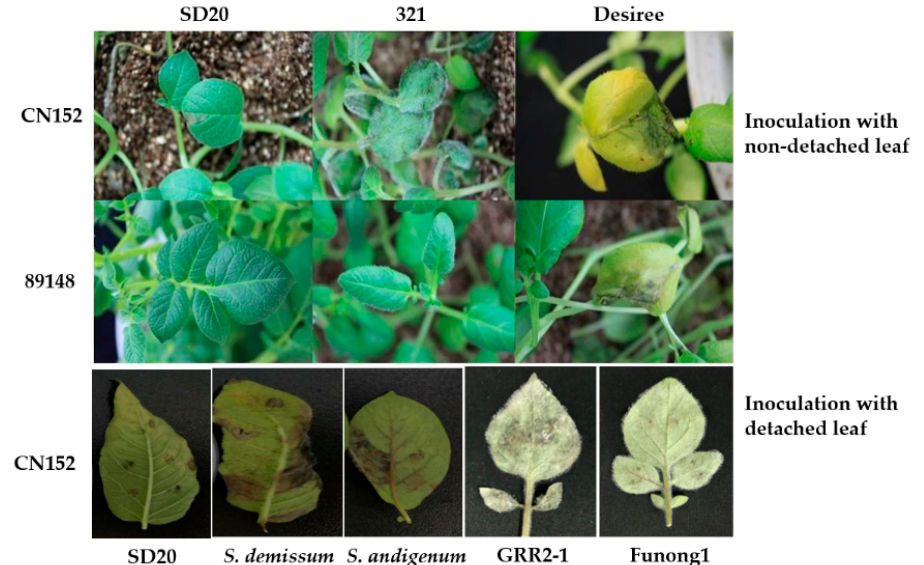
Figure 1. Inoculation with detached and non-detached leaves of different potato accessions using Phytophthora infestans isolates 89148 (race 0) and CN152 (race 1, 3b, 4, 5, 6, 7, 8, 9, 10, 11). SD20 and 321, tetraploid potato genotypes; Desiree, tetraploid potato cultivar as susceptible control; S. demissum and S. andigenum , wild potato species; GRR2-1, potato clone from S. guerreroense ; Funong 1, a released variety in China.